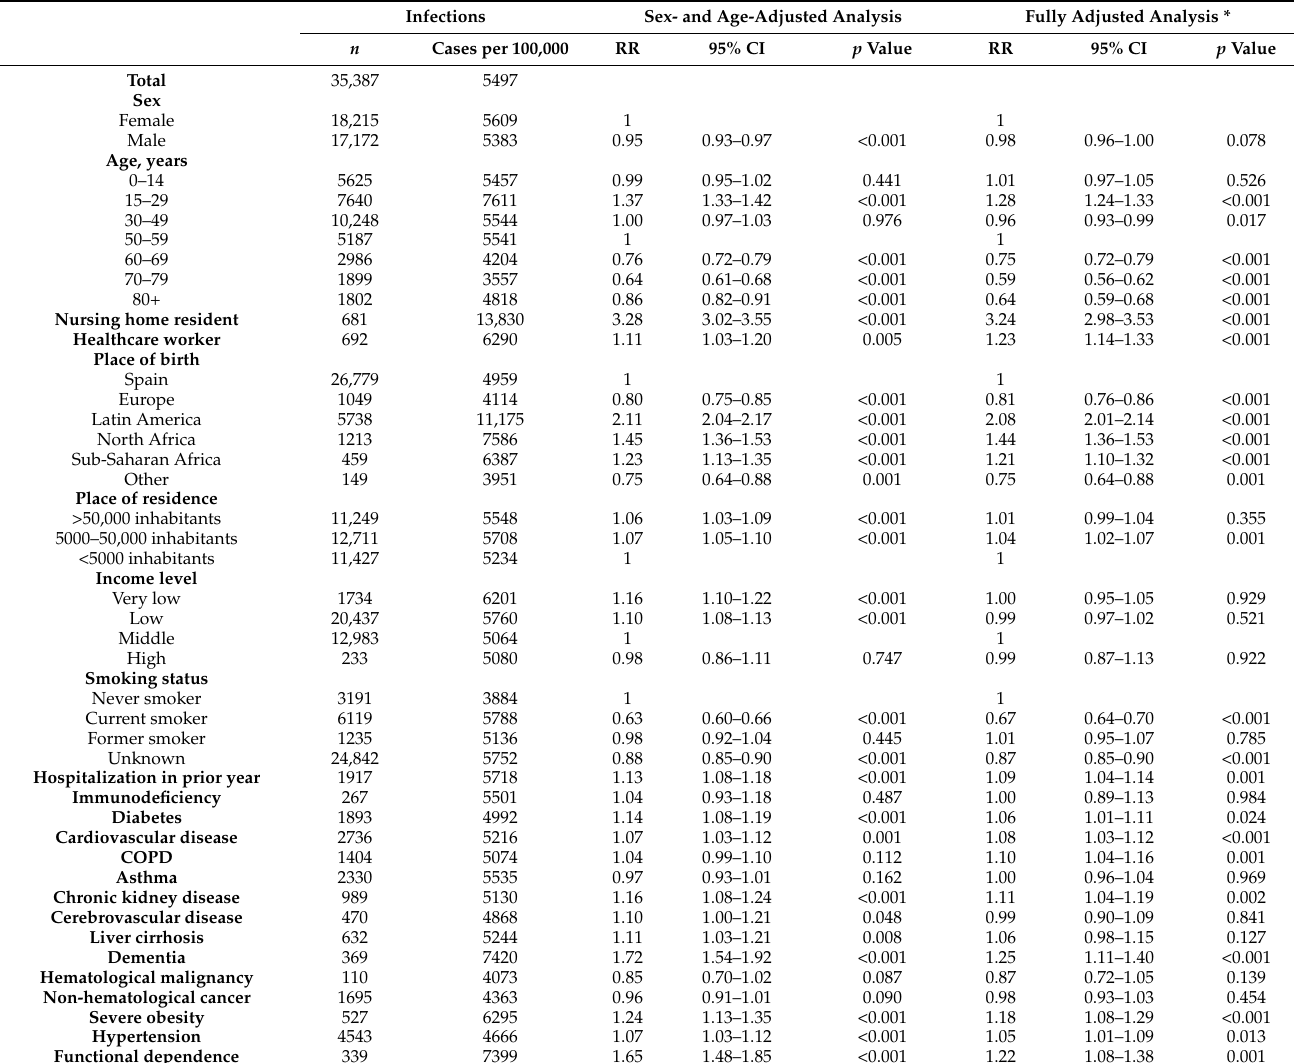
Table 1. Association between potential predictive factors and confirmed SARS-CoV-2 infection in the general population